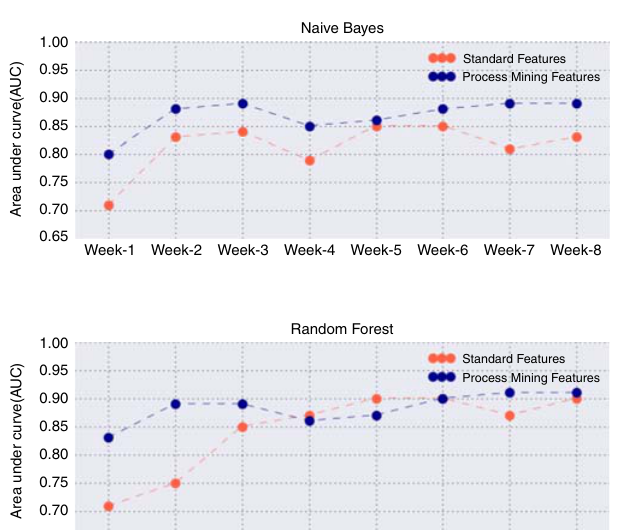
Figure 8. Comparative results of logistic regression method on the data set consisting of process mining features and without process mining